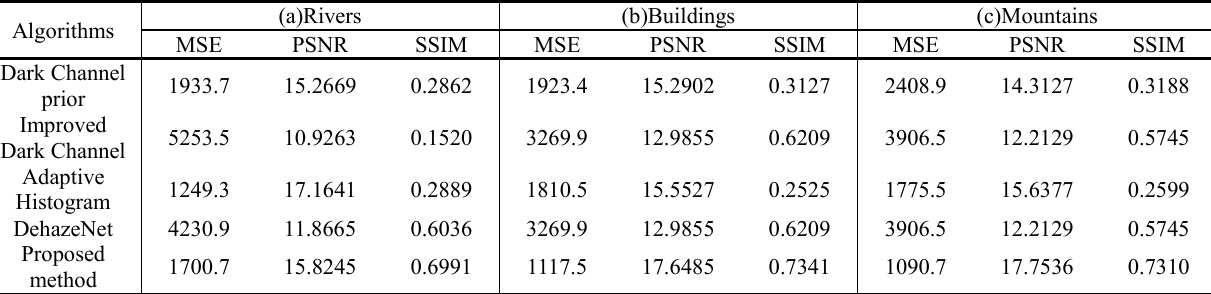
Table 1. Evaluation results of each algorithm on UAV images dehazing of ground objects: (a) In the processing of rivers. (b) In the processing of buildings. (c) In the processing of